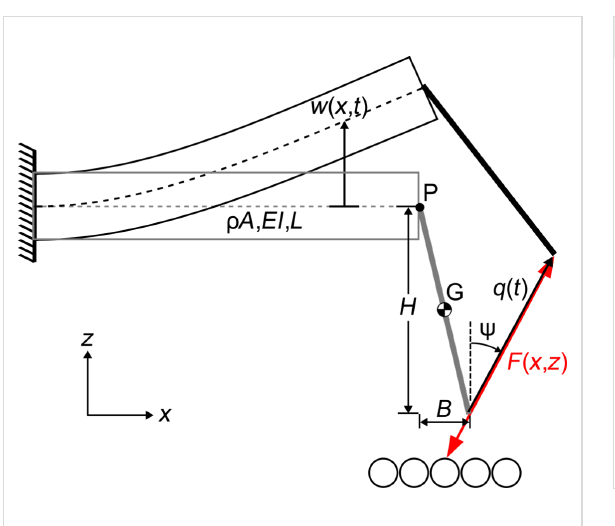
Figure 2: Model schematic for the qPlus sensor. The tine is a uniform beam with linear mass density μ , flexural rigidity EI and length L . The tip is attached to the free-end of the tine at point P corresponding to the neutral axis of the tine. The tip is modeled as a rigid, slender rod with a height H and axial offset B . Point G marks the center of mass of the tip.